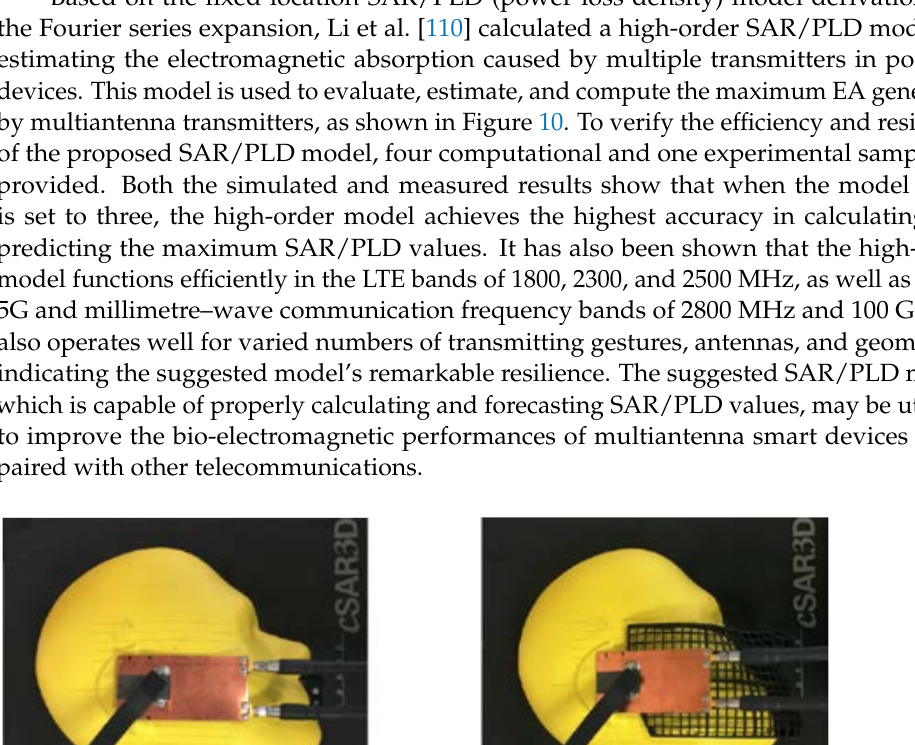
Figure 11. Thermal evaluation system for specific absorption rates: ( a ) system diagram, and ( b ) rec- tangular box-shaped semisolid phantom used for the measurements [109].